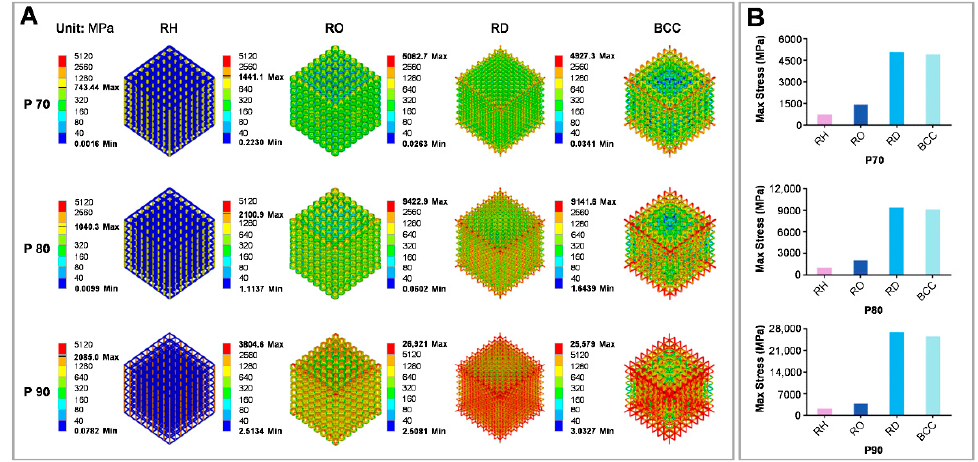
Figure 4. Porous scaffold’s mechanical properties assessed through finite element analysis. ( A ) Von Mises stress distribution for porous scaffolds with varying configurations and porosity under 10 kN compression. ( B ) Maximum von Mises stress values for porous